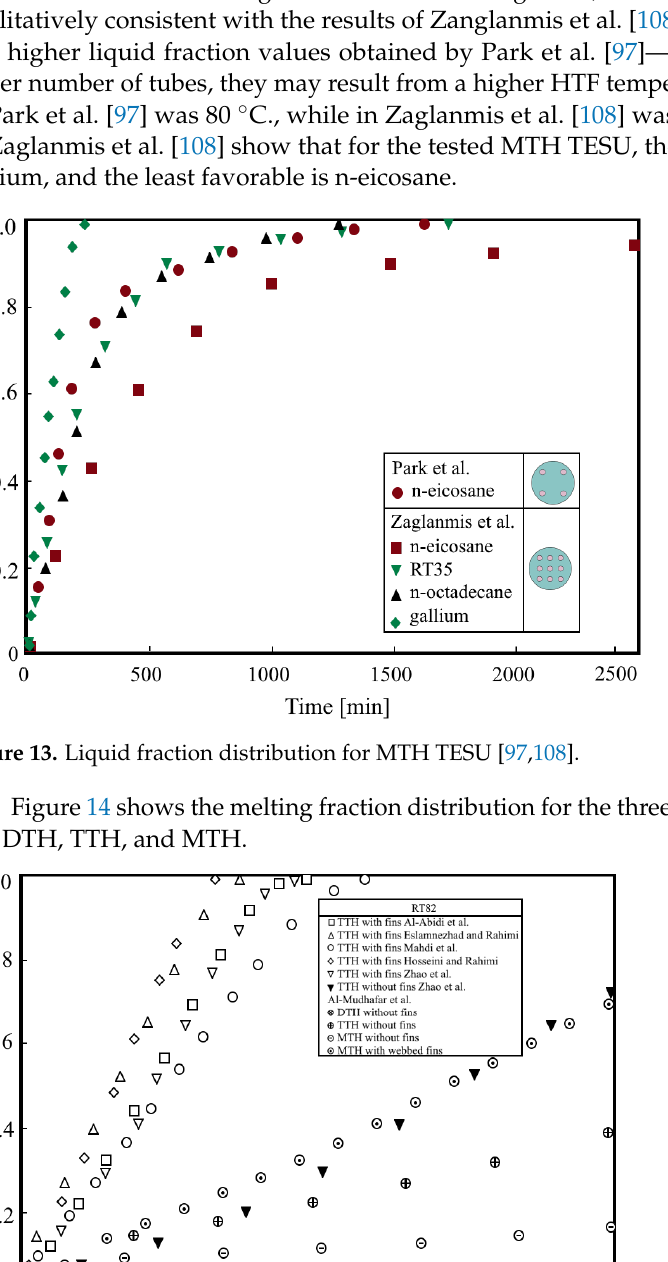
Figure 12. Liquid fraction distribution for TTH TESU [70,80].